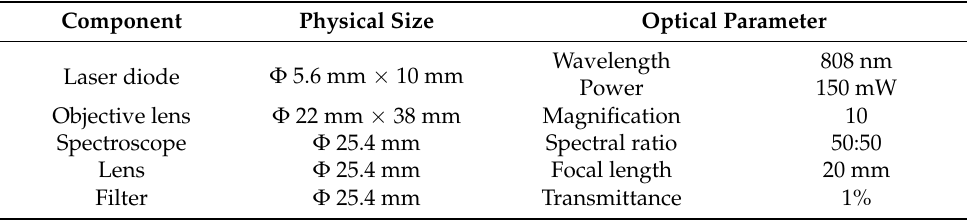
Table 1. Physical and optical parameters of the